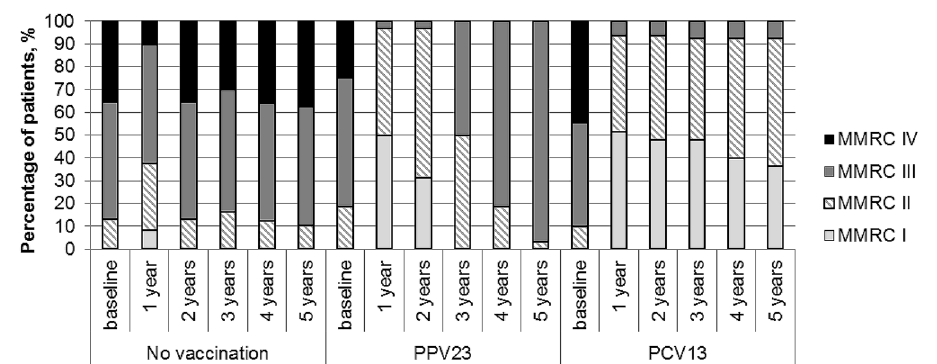
Figure 5. The dynamics of dyspnea severity (MMRC) in the study groups.